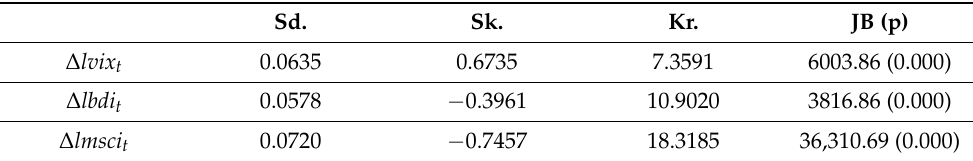
Table 1. Descriptive Statistics for VIX, BDI and MSCI Daily % Returns. Sd. Sk.